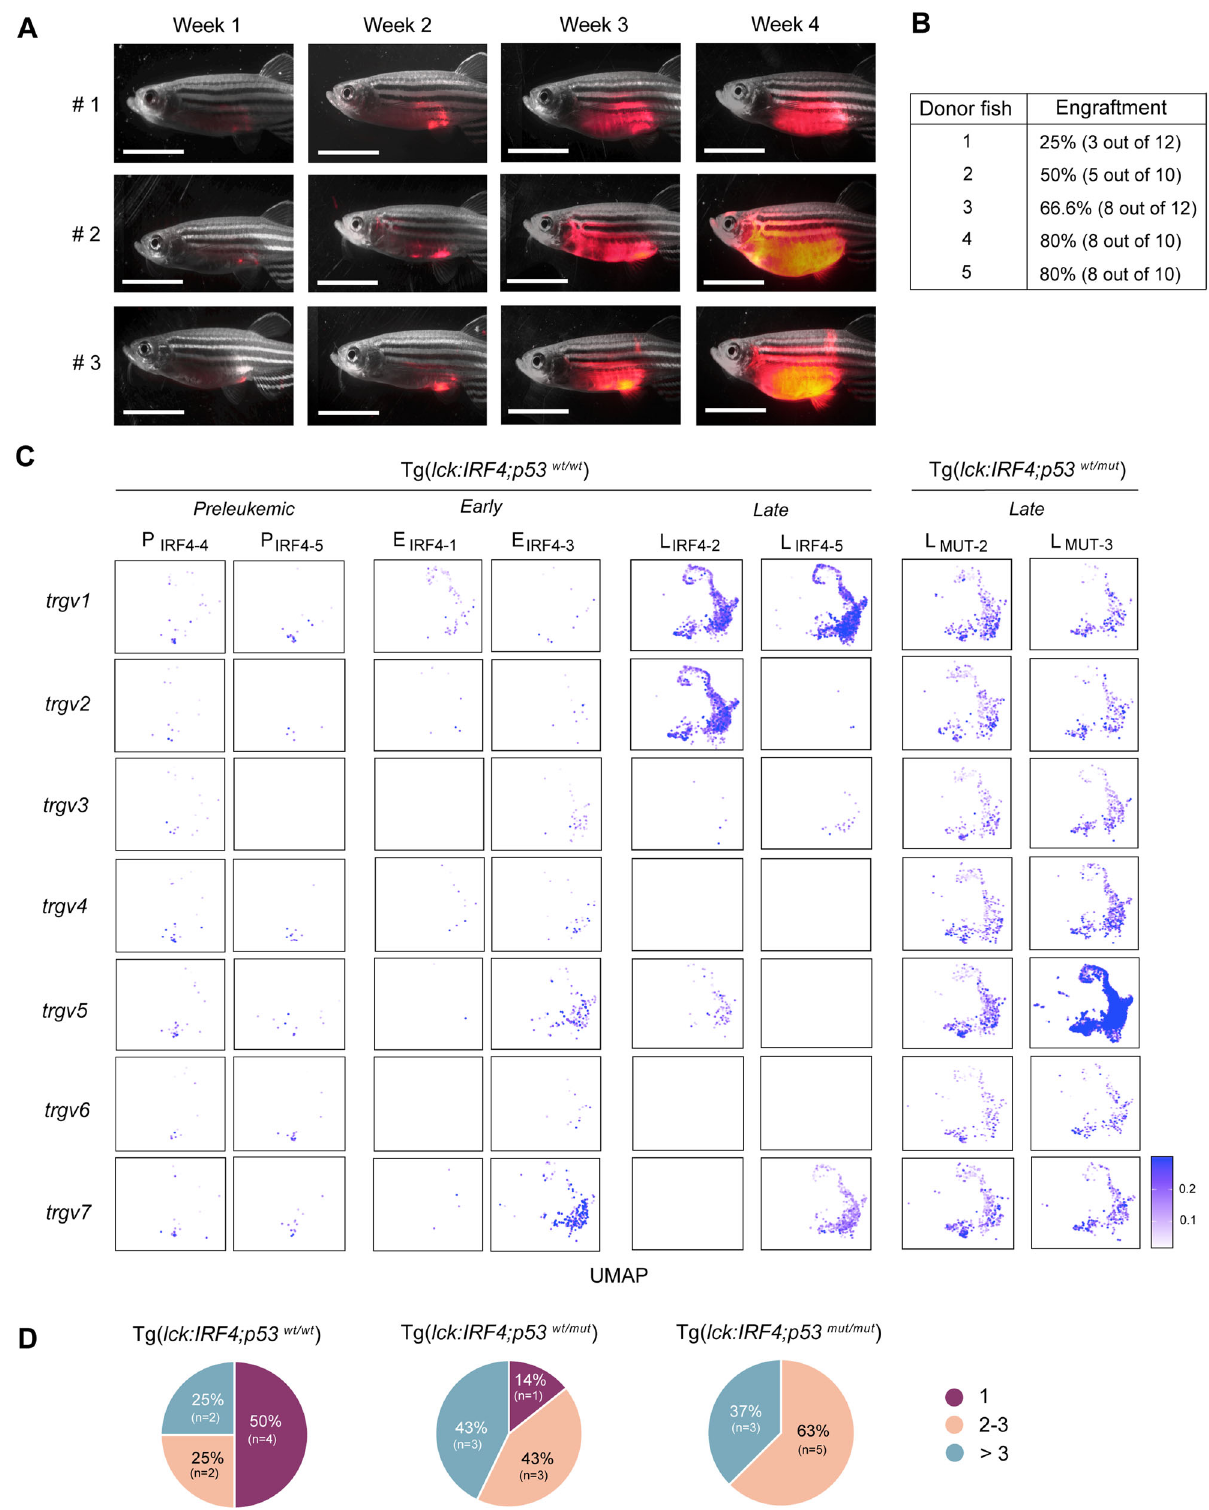
Fig. 4 IRF4-driven tumor cells possess malignant features. A Representative microscopy images of three recipient fi sh at 1, 2, 3, and 4 weeks after the fi rst transplantation. Panels show merged fl uorescence and bright fi eld images. Scale bar = 4 mm. B Table showing the engraftment rate of fi ve independent donor tumor fi sh. C Gene expression pattern of the tcr- γ variable regions in eight representative samples. The cells in the UMAP plot are colored by the marker gene expression level. D Pie charts showing the percentage of mono-, oligo-, and polyclonal tumors analyzed by qRT-PCR in three different genotype settings. Source data are provided as a Source Data fi